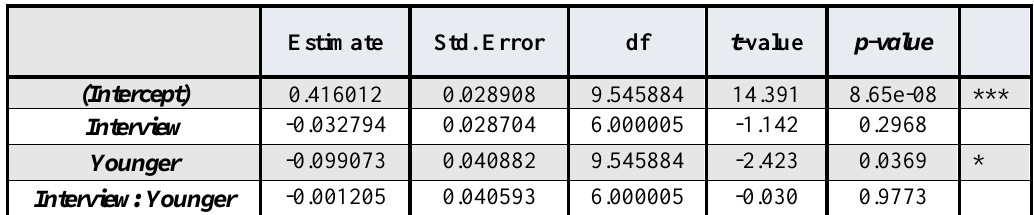
Table 5. Regression coefficients for the mixed linear effects model predicting vowel dispersion. The Intercept coefficient is vowel dispersion from word list productions by older speakers and the estimate are measures of normalized frequency.